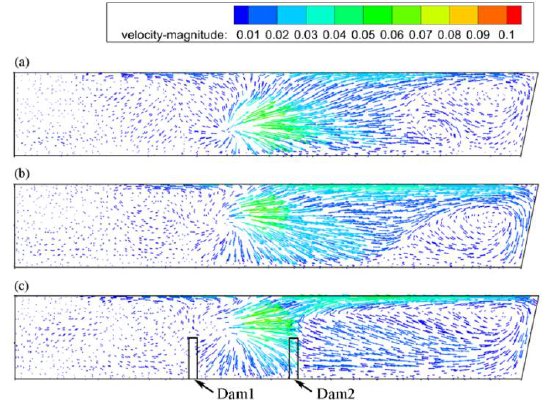
Figure 18. Velocity fields of the front side plane: ( a ) case A0, ( b ) C1, ( c ) C5.